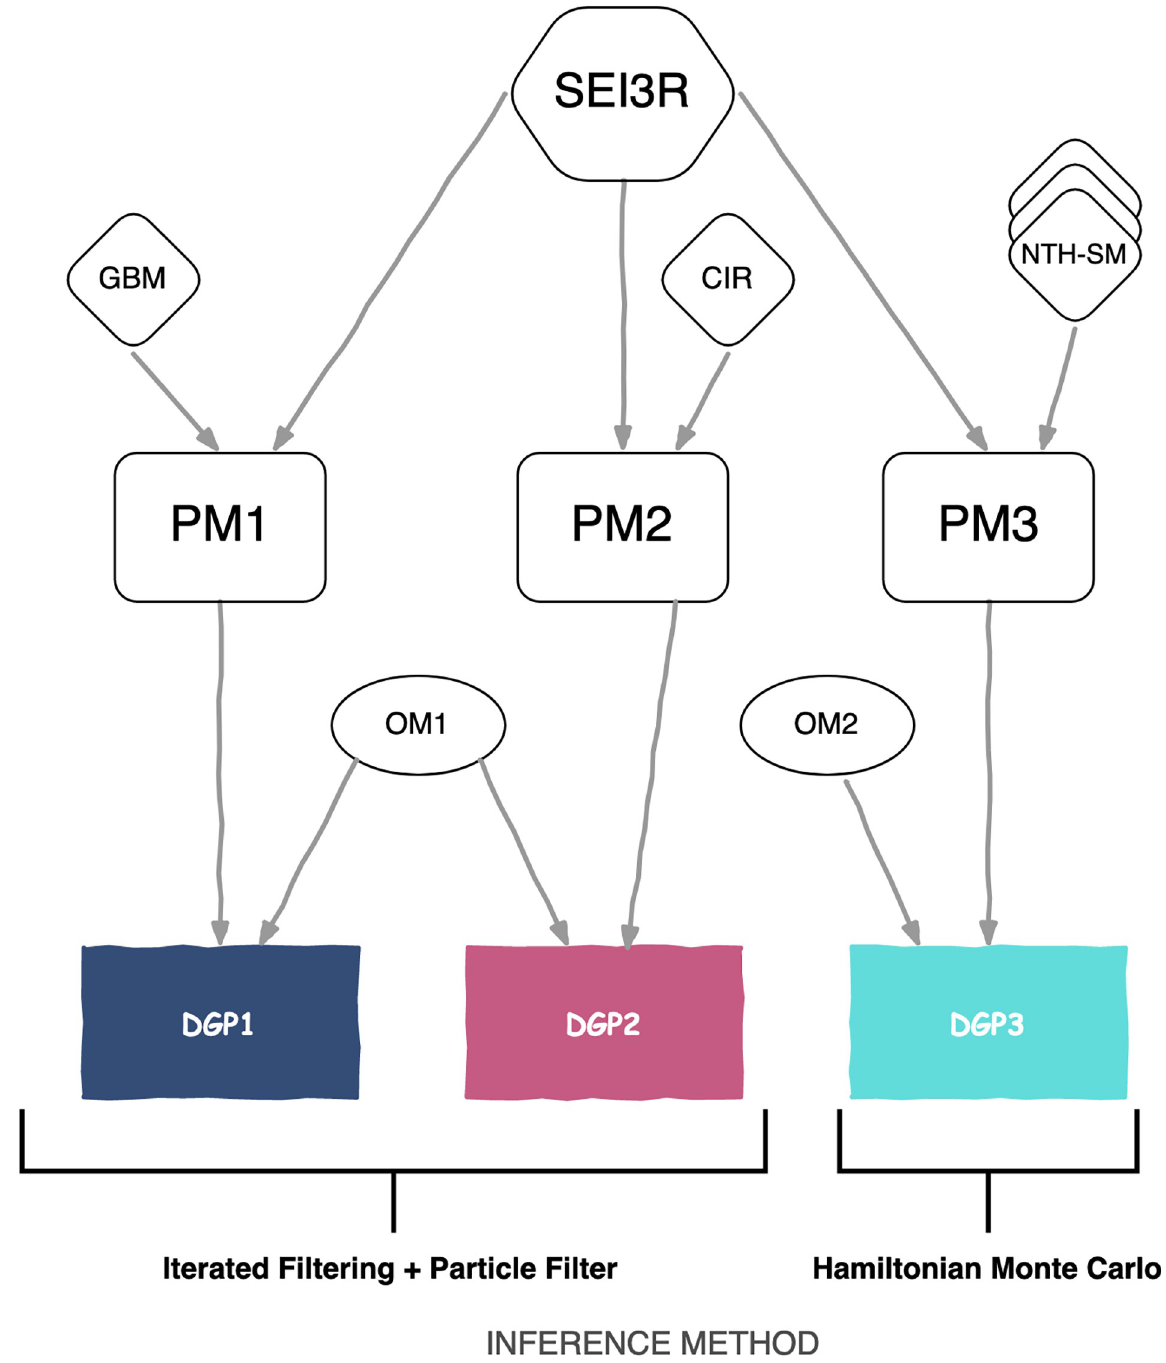
Fig 1. Schematic diagram of the data generating processes (DGPs) explored in this paper. This diagram aims to portray the DGPs as the ensemble of two components: a measurement or observational model (ellipse) and a process model (rounded rectangle). For instance, DGP1 is the amalgamation of the measurement model OM1 and the process model PM1. The process model is in turn the ensamble of two structures: a within-host profile (hexagon) and a time-dependent transmission rate (rhombus). Whereas all process models share a common within-host profile (SEI3R), they differ in the formulation of the transmission rate: Geometric Brownian Motion (GBM), Cox-Ingersoll-Ross (CIR), and nth- order exponential smoothing (NTH-SM). The inference method employed on each DGP depends upon the nature of the process model (Iterated Filtering + Particle Filter for stochastic structures and Hamiltonian Monte Carlo for deterministic ones).